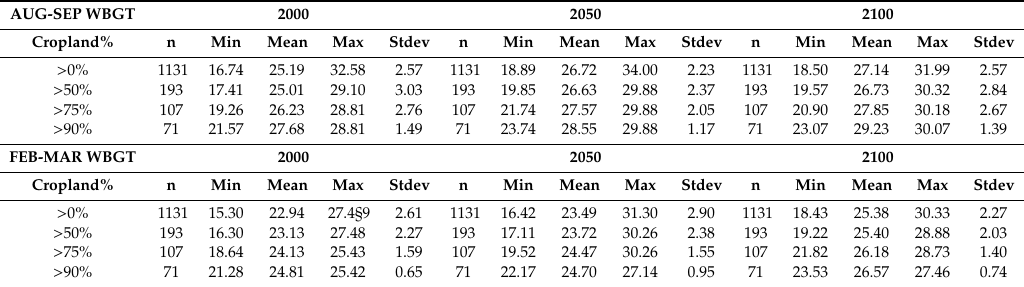
Table 5. Maximum daily WBGT per grid cell, disaggregated to areal cropland percentage for the months of February–March and August–September for the years 2000, 2050 and 2100. The values